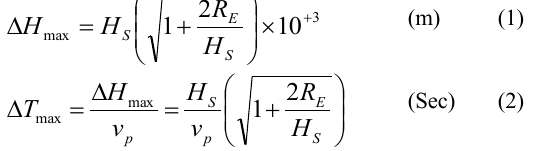
Figure. 2. Snapshotted geometrical arrangements to calculate the spoofing results. GPS constellation is selected as an example and the model is valid for any GNSS